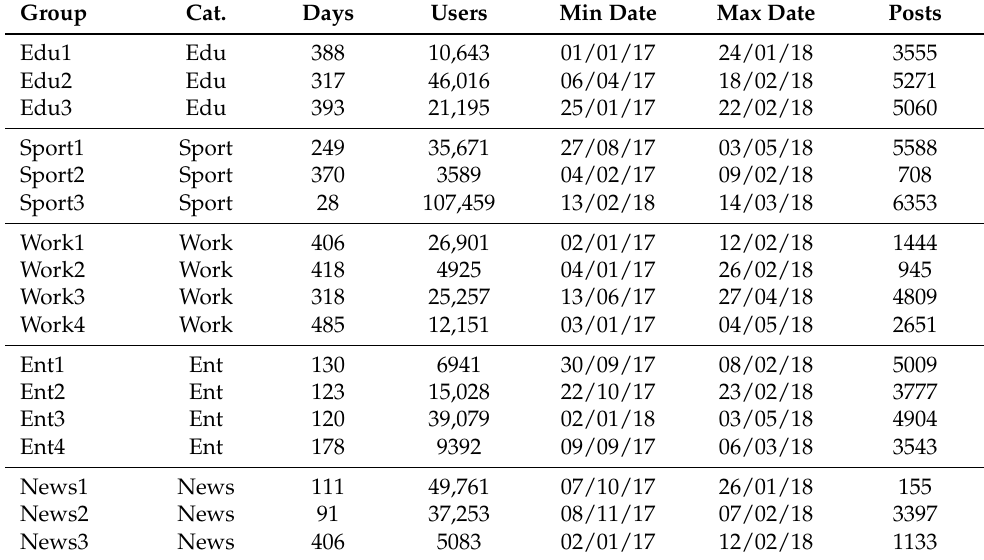
Table 1. General description of the Facebook Groups. Group